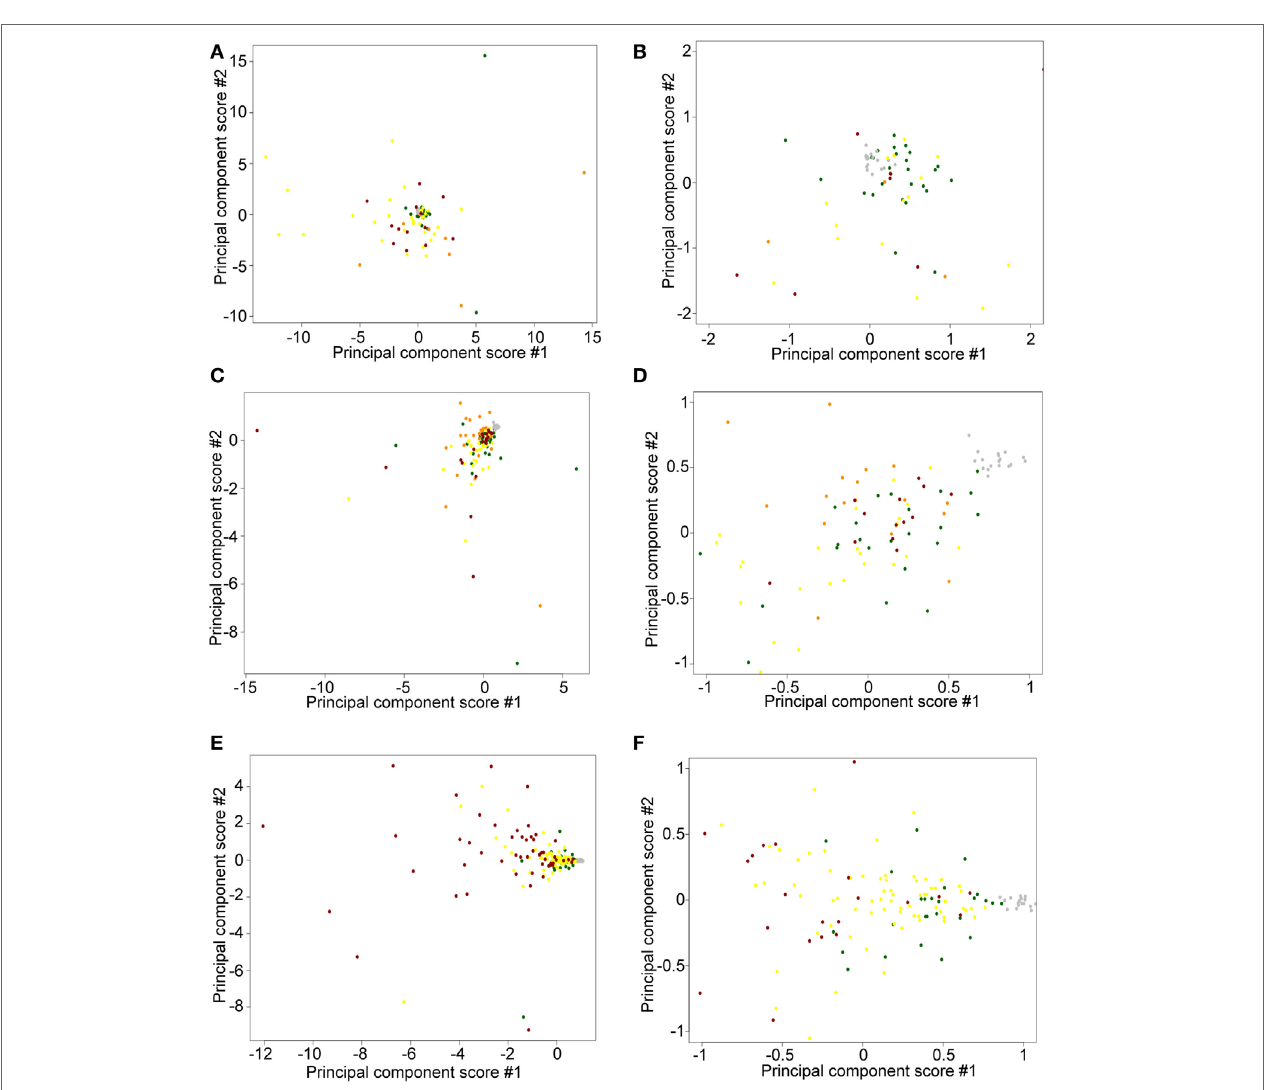
FigUre 7 | Principal component score plots. (a,B) First and second principal component scores of normal/benign (green), freshly obtained and liquid nitrogen snapped-frozen cutaneous T-cell lymphoma (CTCL) (gray), ≤ 2008 early-stage formalin-fixed paraffin-embedded (FFPE) CTCL (yellow), ≤ 2008 mid-stage FFPE CTCL (orange), and ≤ 2008 advanced stage FFPE CTCL (red) samples are plotted. (c,D) First and second principal component scores of normal/benign (green), freshly obtained and liquid nitrogen snapped-frozen CTCL (gray), ≥ 2009 early-stage FFPE CTCL (yellow), ≥ 2009 mid-stage FFPE CTCL (orange), and ≥ 2009 advanced stage FFPE CTCL (red) samples are plotted. (e,F) First and second principal component scores of normal/benign (green), freshly obtained, and liquid nitrogen snapped-frozen CTCL (gray), ≤ 2008 FFPE CTCL (red), and ≥ 2009 FFPE CTCL (yellow) samples are plotted.